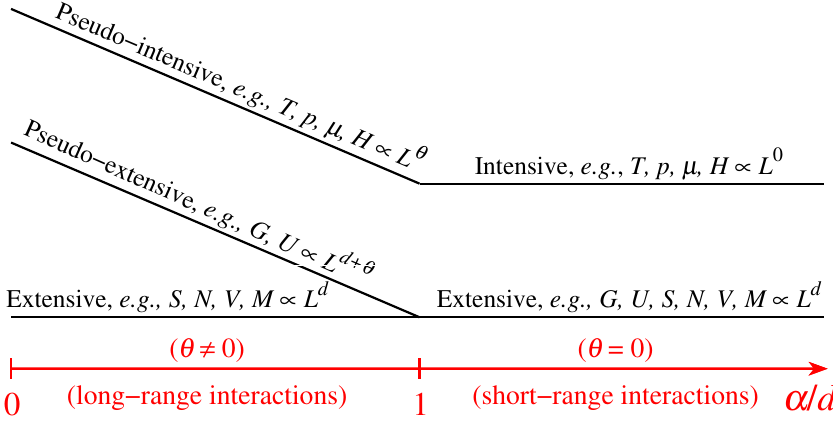
Figure 3. Schematic representation of the different scaling regimes for classical d -dimensional systems. In the case of attractive long-ranged interactions (i.e., 0 ≤ α / d ≤ 1, α characterizing the interaction range in a potential with the form 1/ r α ; for example, Newtonian gravitation corresponds to ( d , α ) = ( 3,1 ) ), we may distinguish three classes of thermodynamic variables, namely, those scaling with L θ , named pseudo-intensive ( L is a characteristic linear length, θ is a system-dependent parameter), those scaling with L d + θ with θ = d − α , the pseudo-extensive ones (the energies), and those scaling with L d (which are always extensive). In the case of short-ranged interactions (i.e., α > d ), we have θ = 0 and the energies recover their standard L d extensive scaling, falling within the same class of S , N , V , M , etc., whereas the previous pseudo-intensive variables become truly intensive ones (independent of L ); this is the region, with only two classes of variables that is covered by the traditional textbooks of thermodynamics. From